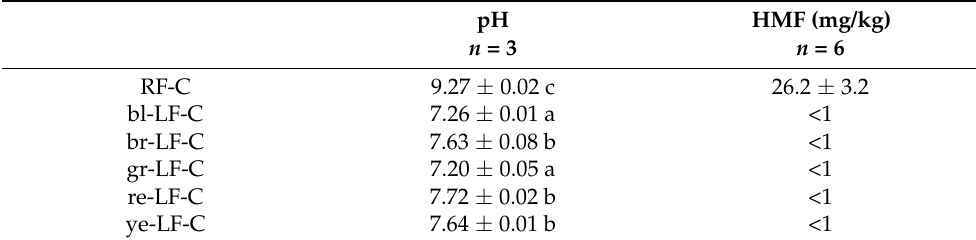
Table 8. pH and hydroxymethyl-furfural content of lentil and rice cookies.